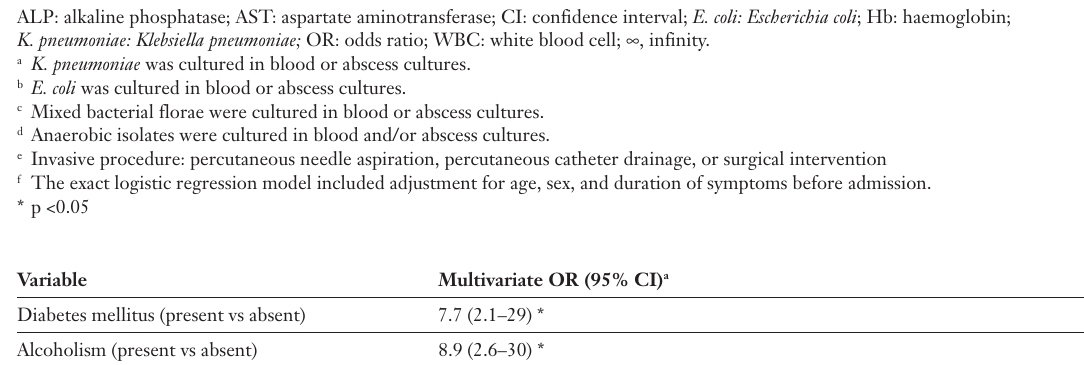
Multivariate analysis of risk factors in relation to develop- ment of metastatic infection from pyo- genic liver abscesses (n =